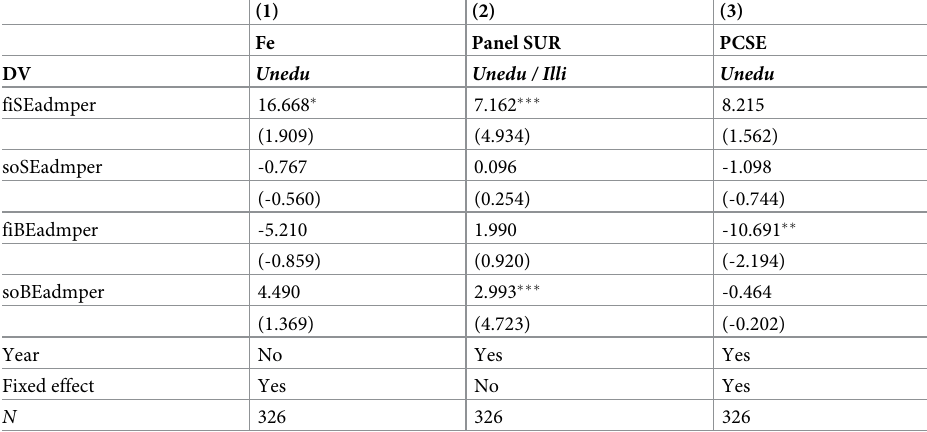
Table 4. The results of administrative expense on RSE